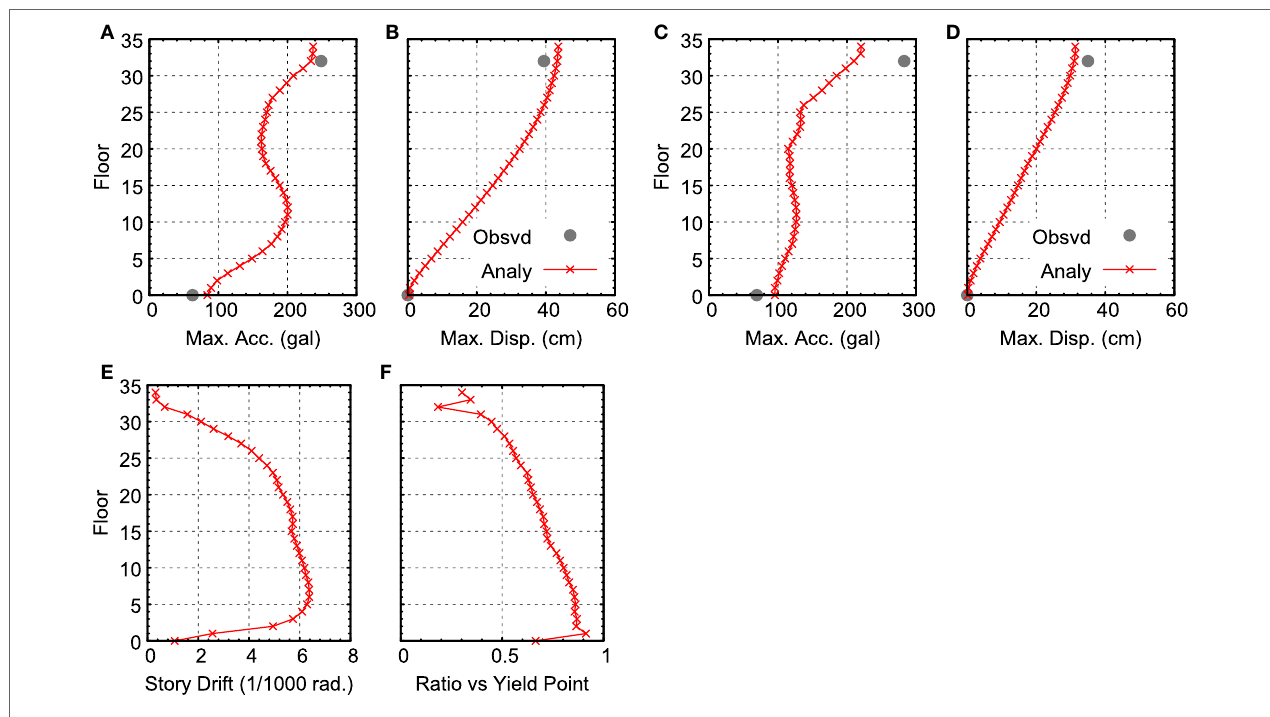
FigUre 9 | Comparison of maximum response for the 3/11 main shock: (a) maximum acceleration (N–S direction), (B) maximum displacement (N–S direction), (c) maximum acceleration (E–W direction), (D) maximum displacement (E–W direction), (e) distribution of story drift angle (N–S direction), and (F) distribution of ductility factor (N–S direction).